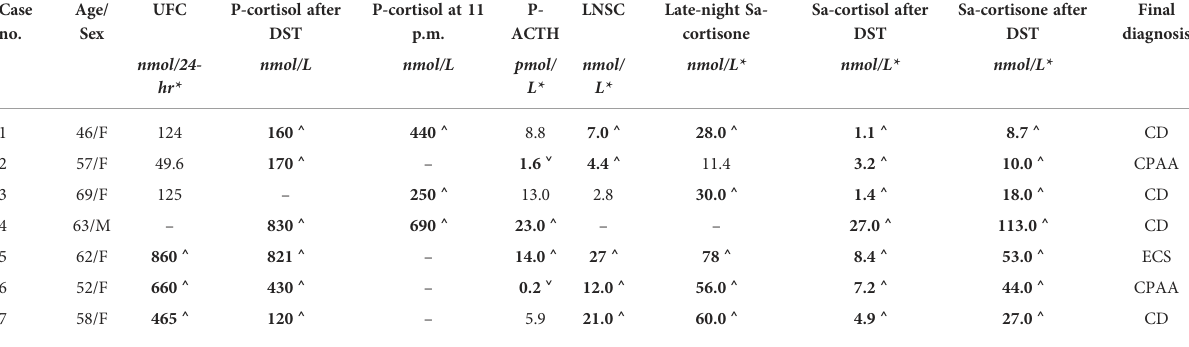
TABLE 4 Individual data on patients diagnosed with Cushing ’ s syndrome. Case